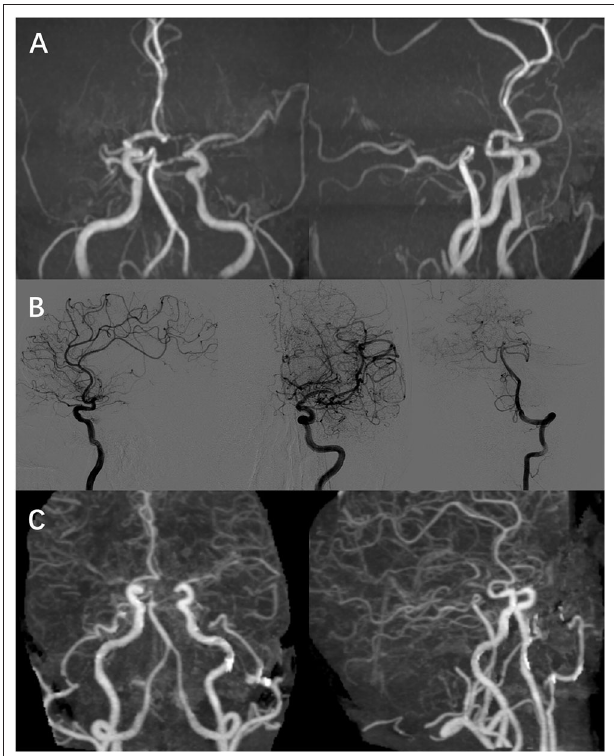
FIGURE 3 | Image result of cerebral vessels. (A,B) MRA and DSA showed that right MCA was occulted as well as bilateral terminal ICA, and the left MCA, ACA, and PCA were narrow, which was accompanied with “puff-of-smoke” vessels. (C) CTA showed “puff-of-smoke” vessels and meningeal branch neovascularization after the 2-stage bilateral STA bypass surgery. ICA, internal carotid artery; MCA, middle cerebral arteries; ACA, anterior cerebral arteries; CTA, computed tomography angiography.